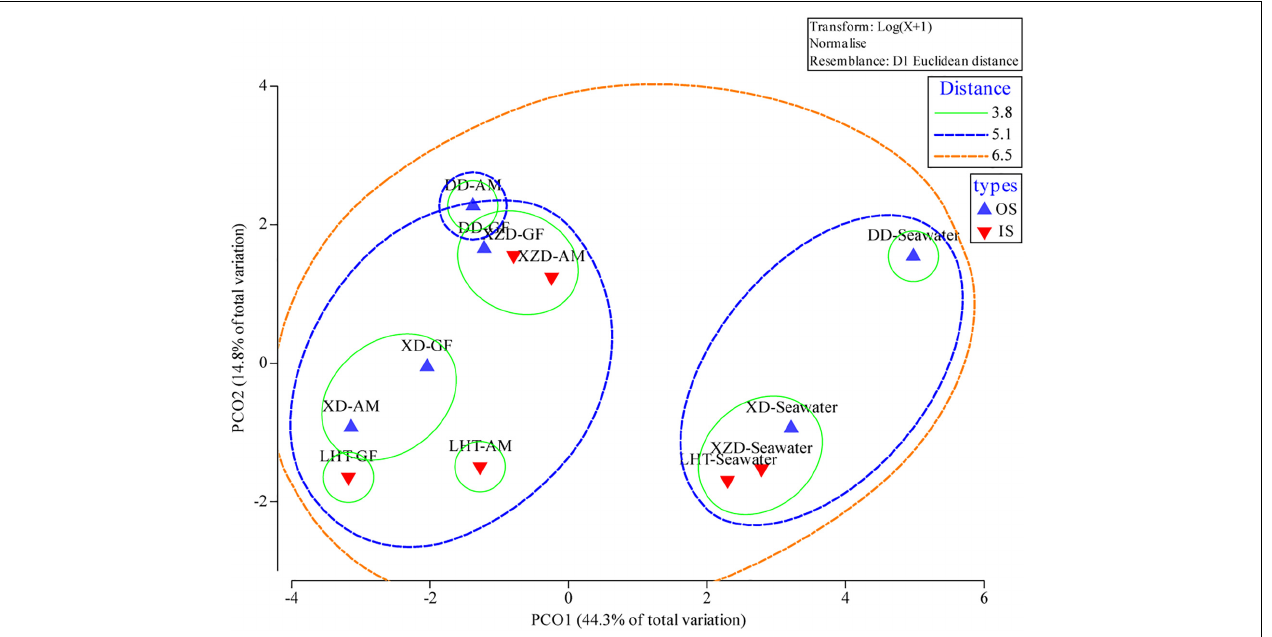
FIGURE 4 | PCO combined with cluster analysis showed the MPs distribution patterns in coral and seawater. XD, Xidao; DD, Dongdao; XZD, Xiaozhoudao; LHT, Luhuitou; AM, A. millepora ; GF, G. fascicularis